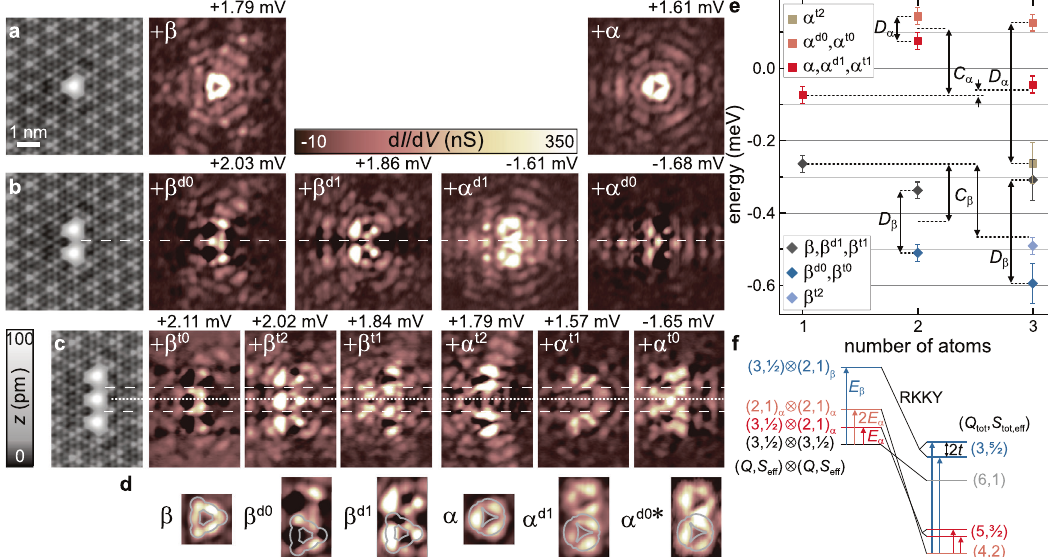
Fig. 3 YSR wave functions of monomer, dimer and trimer. a – c STM topographies (constant-current mode with set point 100 pA, 10 mV) of one to three Fe atoms with spacing of 3 a in the left. Corresponding constant-contour d I /d V maps of the (hybridized) YSR states in the monomer (top row), dimer (middle row) and trimer (bottom row). Constant-contour feedback was opened at 250 pA, 5 mV and a modulation of 15 μ V was used. Horizontal dashed/ dotted lines serve as guide to the eye. d Close-ups around the atoms' center for the monomer and dimer α and β states. Gray lines serve as guide to the eye. e Quantitative energy evolution of the α and β states upon hybridization. Shift C relative to the monomer and splits D are indicated. Note that the CDW-induced energetic evolution of the monomer YSR states suggests α and β to be in the screened-spin regime 56 , hence, implying a negative ground state energy (of the monomer states). The position of the α and β states were determined from deconvolved spectra, which were fi t by the appropriate number of Gaussian peaks. The error bars were determined from the standard deviation of the fi t, the error margin of the energy gap of the tip, the modulation voltage of the lock-in, and the sampling interval of the data used for the deconvolution, for details see Supplementary Note 6. f Schematic energy level diagram of the dimer. States of the uncoupled dimer (left) are labeled by ( Q , S eff ) for both adatoms. States of the coupled dimer (right) are labeled by the total number of bound quasiparticles and effective spin, ( Q tot , S tot,eff ). The values of S tot,eff assume ferromagnetic RKKY coupling as suggested by band formation in chains (see